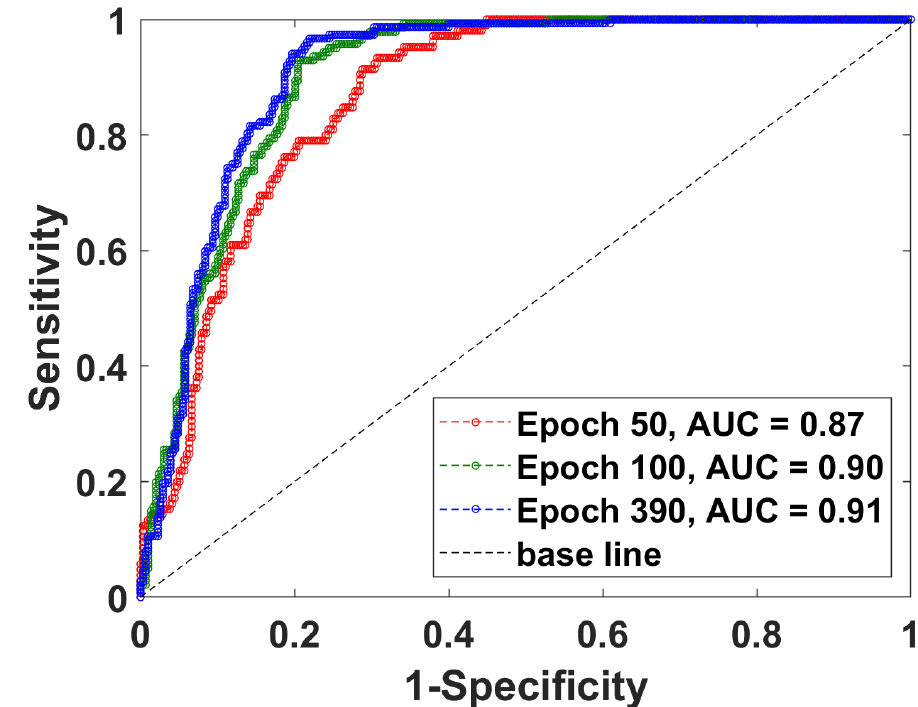
Figure 6. Gland capturing performances at three training epochs. The network’s gland classification performance is shown at three different training epochs, the 50th, 100th, and 390th, as indicated. The AUC (area under the ROC curve) is 0.87, 0.90, and 0.91, respectively.